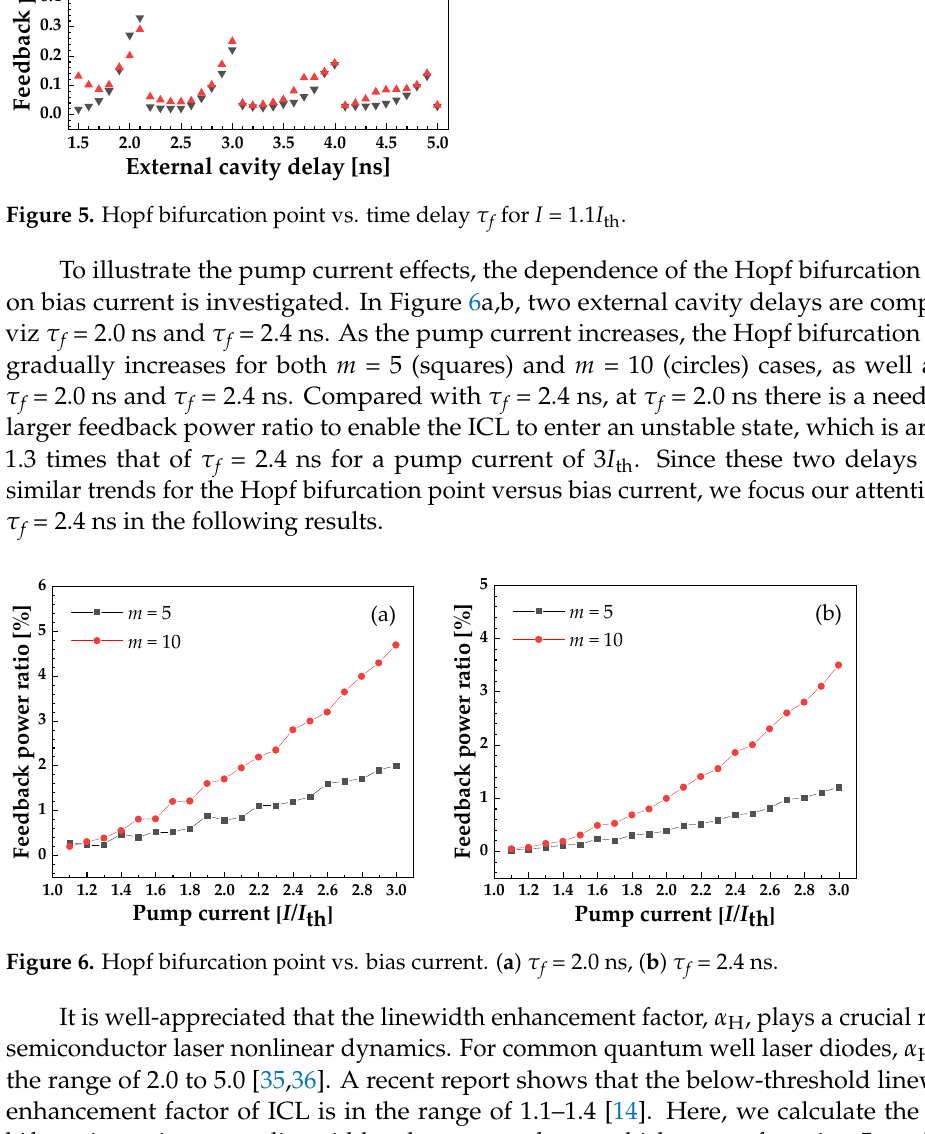
f for I = 1.1 I th .